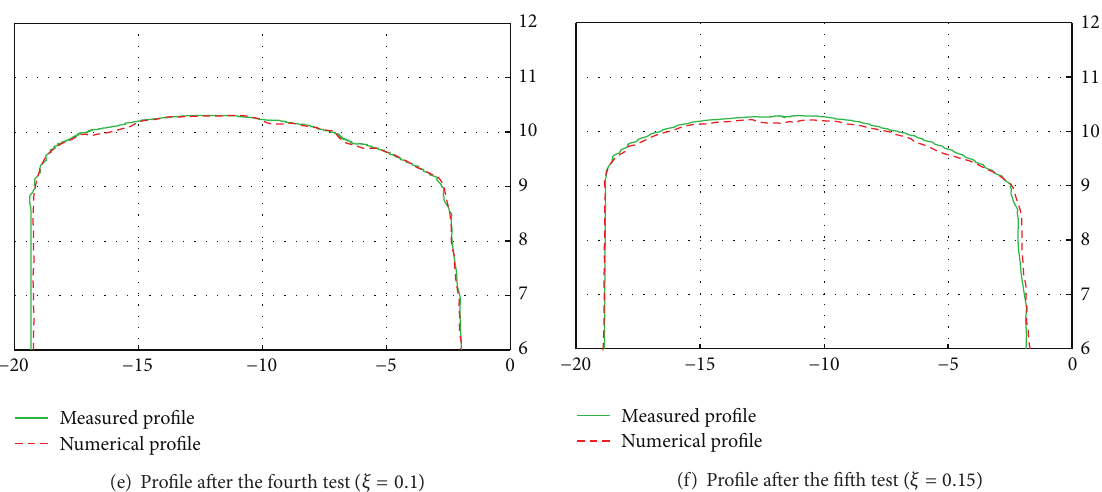
Figure 10: Shape of the roller profile after the tests (units in mm): comparison of the measured and the numerical results (all the tests are performed with a reference speed of 500 rpm except the last one, performed at 250